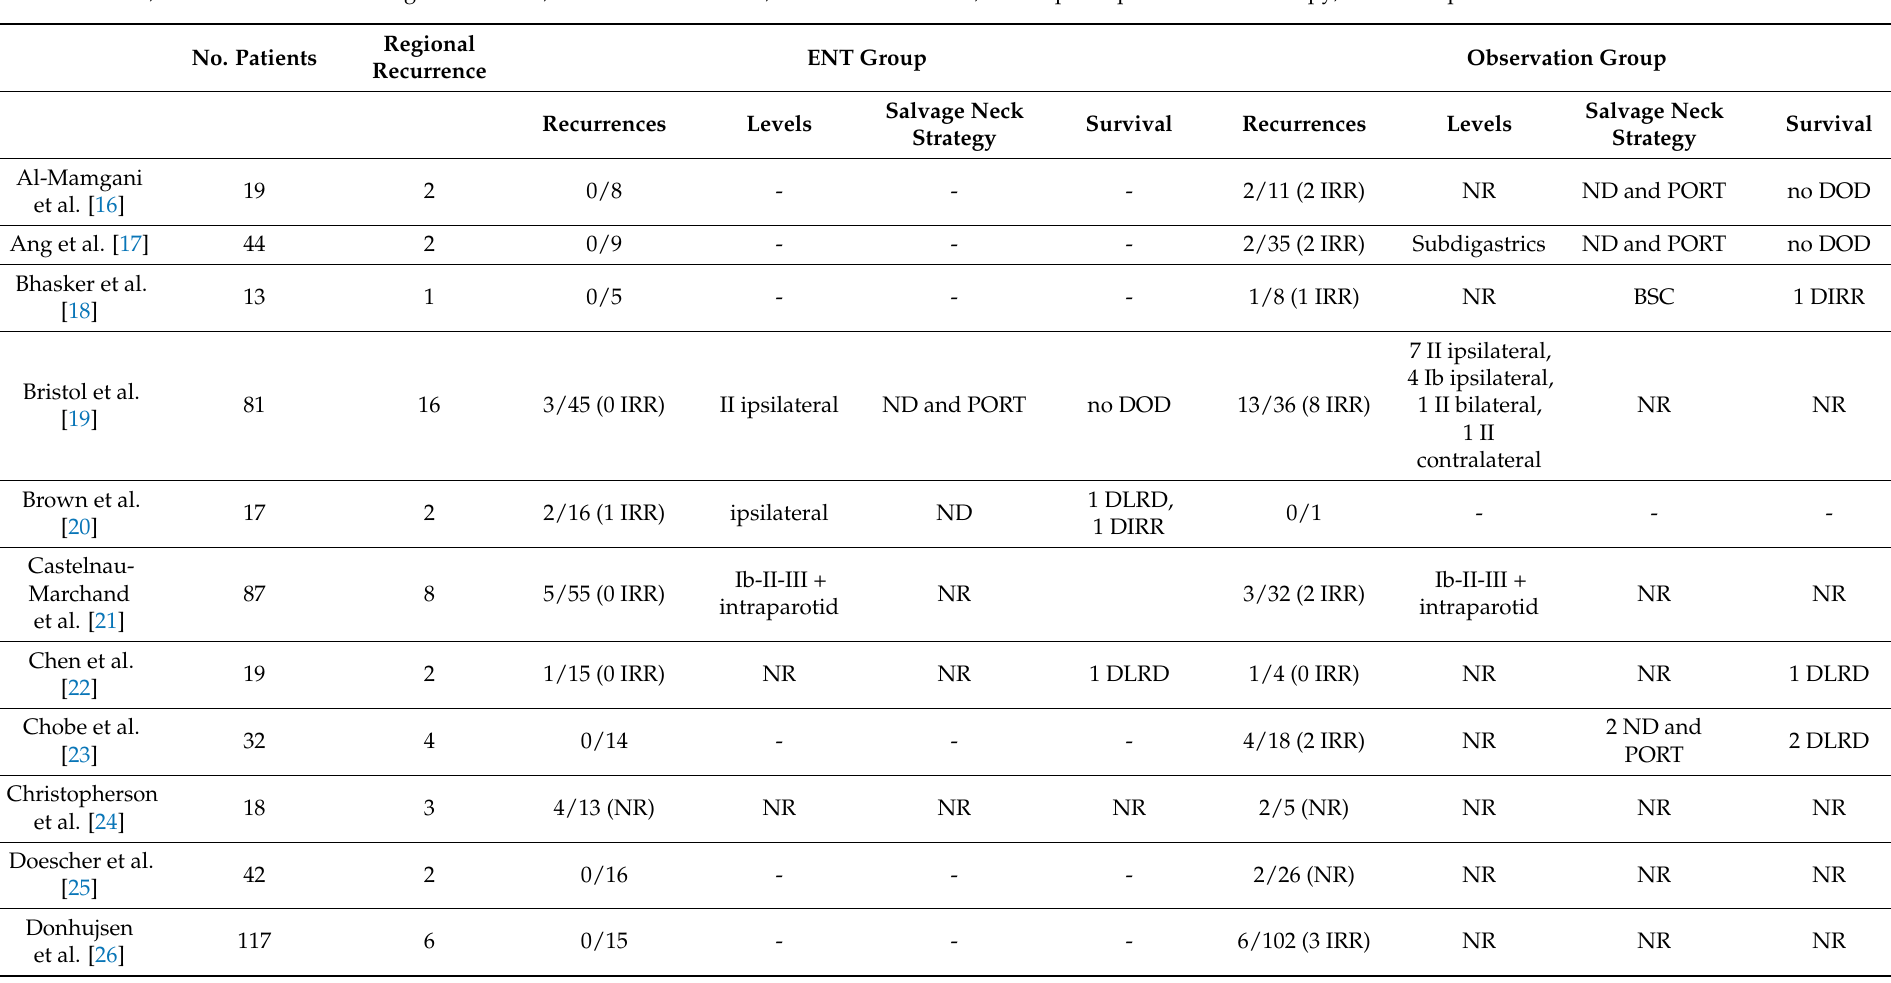
Table 2. Regional recurrence in N0 patients according to the type of neck management. BSC: best supportive care; IRR: isolated regional recurrence; DIRR: dead from isolated regional recurrence; DLRD: dead from locoregional disease; DOD: died of disease; ND: neck dissection; PORT: post-operative radiotherapy; NR: not